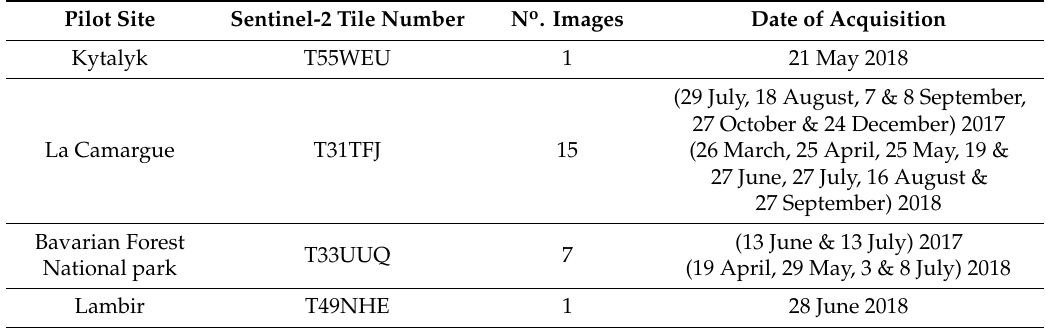
Table 1. Tiles and acquisition dates of the downloaded Sentinel-2 images for the four pilot sites. Pilot Site N o . Images